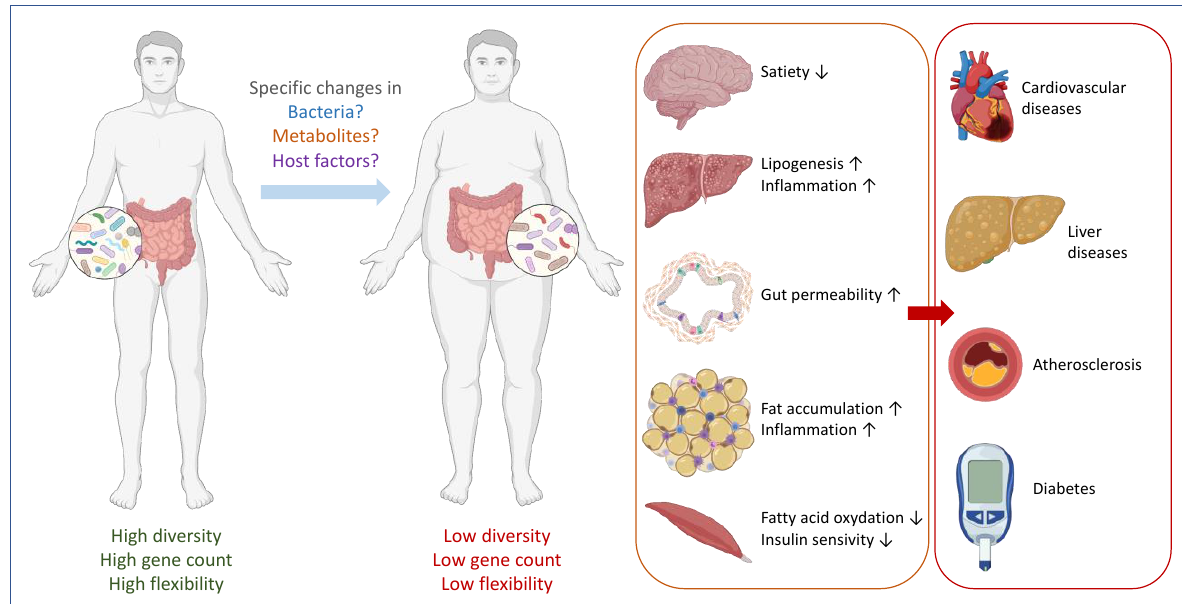
Figure 1. Gut microbes are linked with metabolic disorder. In a healthy situation, the composition of the gut microbiome is associated with a high diversity, high gene counts (high functionality) and a high capacity to adapt to potential stress conditions. An imbalance caused by specific changes in bacteria composition, metabolites production and/or host factors may result in a specific change in the microbiota with a state of low diversity and low gene counts, and poor flexibility. Poor flexibility means a lack of resilience or a difficulty to turn back to a basal and stable state. This contributes to an increased low-grade inflammation and organ malfunctions that in turn can lead to metabolic disorders, such as cardiometabolic conditions, liver diseases and (pre-)diabetes.